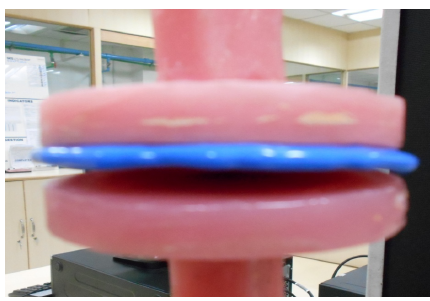
Figure 7. Impression material separa3on at maximum load.